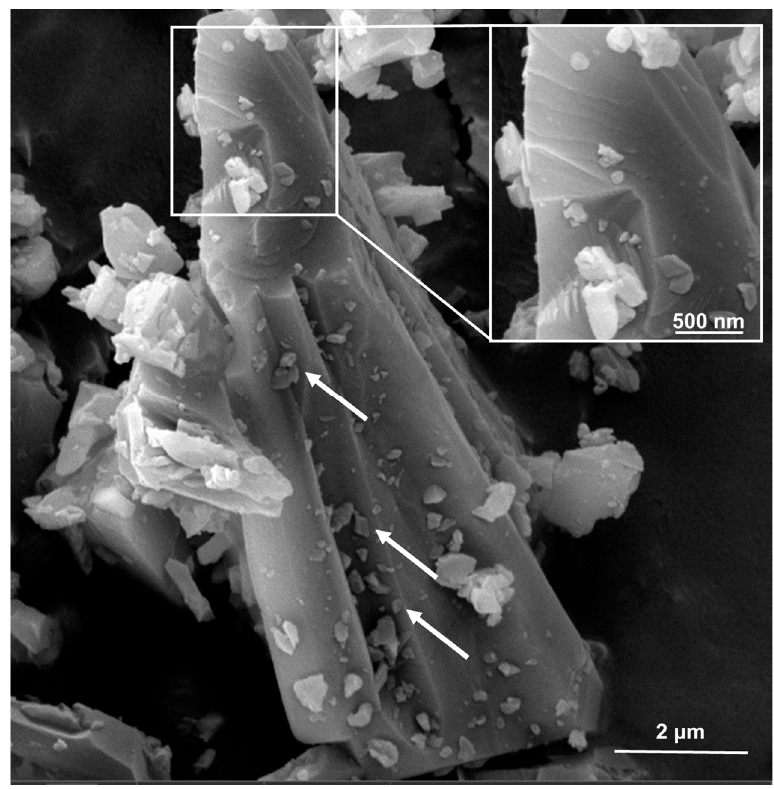
Figure 1. Scanning Electron Microscopy (SEM) micrographs of a respirable crystalline silica dust of industrial origin (cQ-f, in this work). Nanometric particles (highlighted by the white arrows) adhere on the surface of micrometric